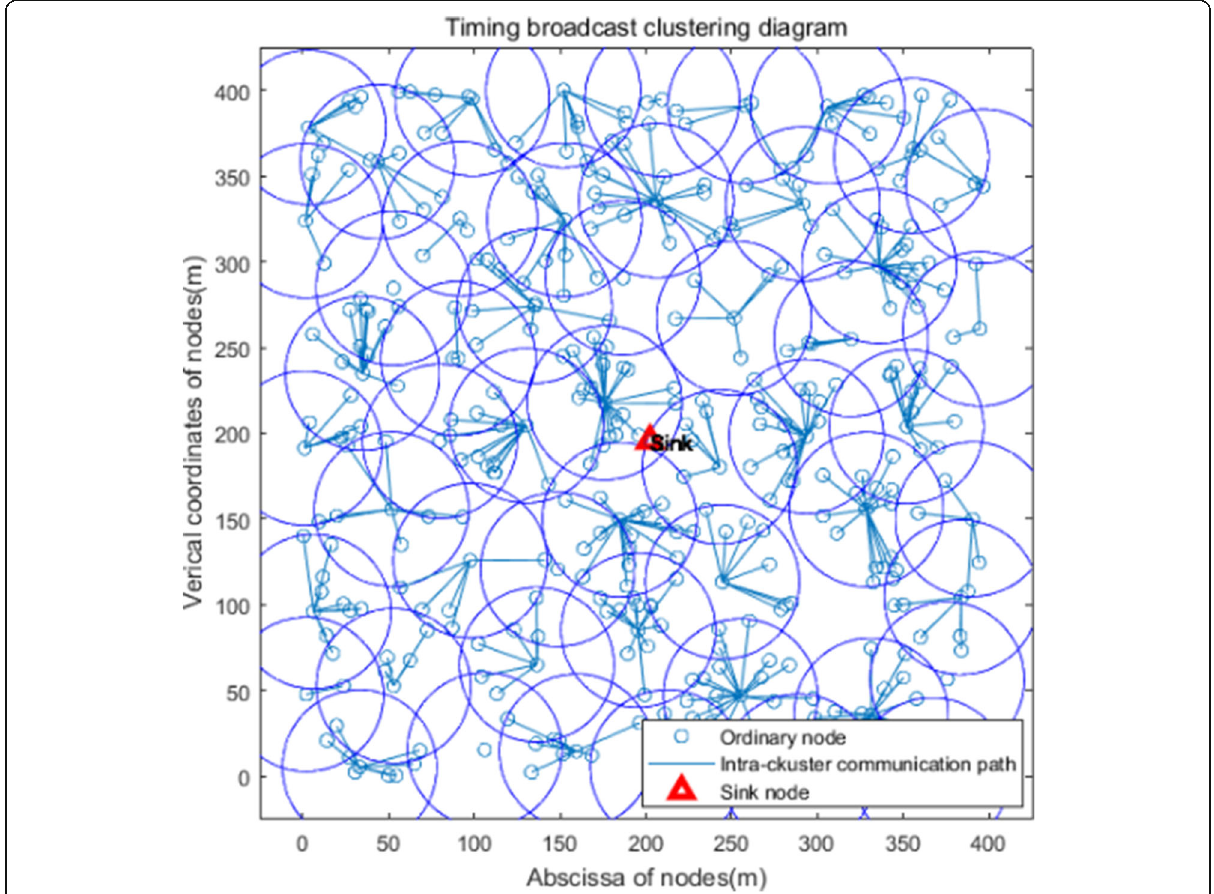
Fig. 3 Timing broadcast clustering. The picture shows the distribution of clusters after the completion of clustering